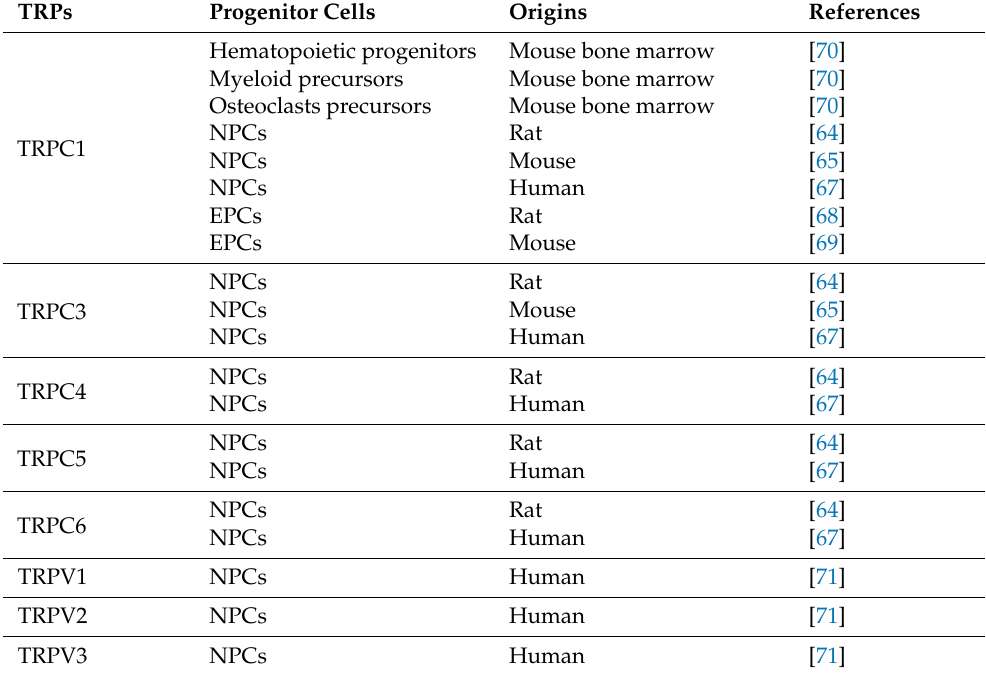
Table 3. TRPs distributed in progenitor